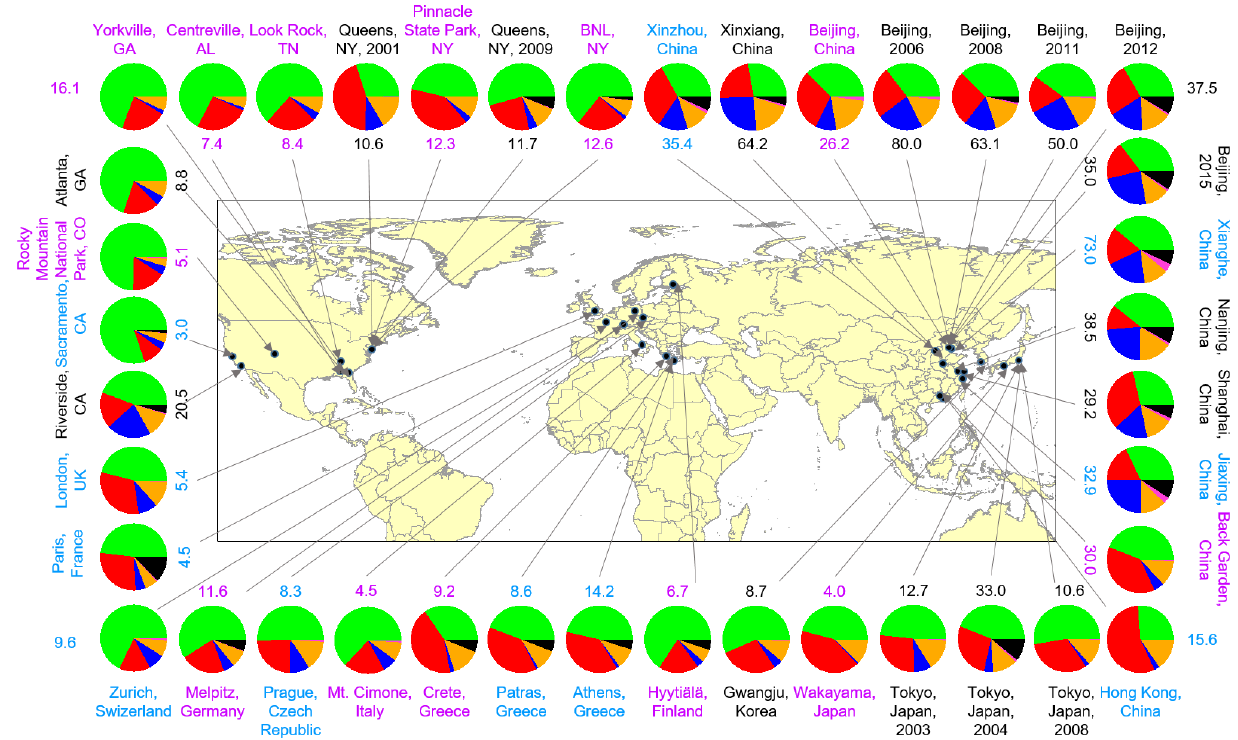
Figure 9. Summary of the submicron particle measurements using ACSM or Aerosol Mass Spectrometer in Asia, Europe, and North America (data given in Table S1 in the Supplement). Colors for the study labels indicate the type of sampling location: urban areas (black), urban downwind areas (blue), and rural/remote areas (pink). The pie charts show the average mass concentration and chemical composition of PM 1 or NR-PM 1 : organics (green), sulfate (red), nitrate (blue), ammonium (orange), chloride (purple), and BC